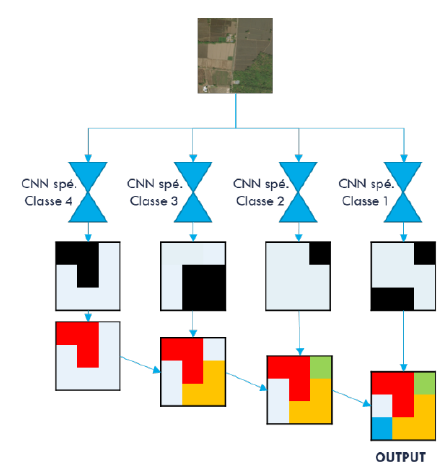
Figure 6. Architecture with fusion of 4 specialized binary networks